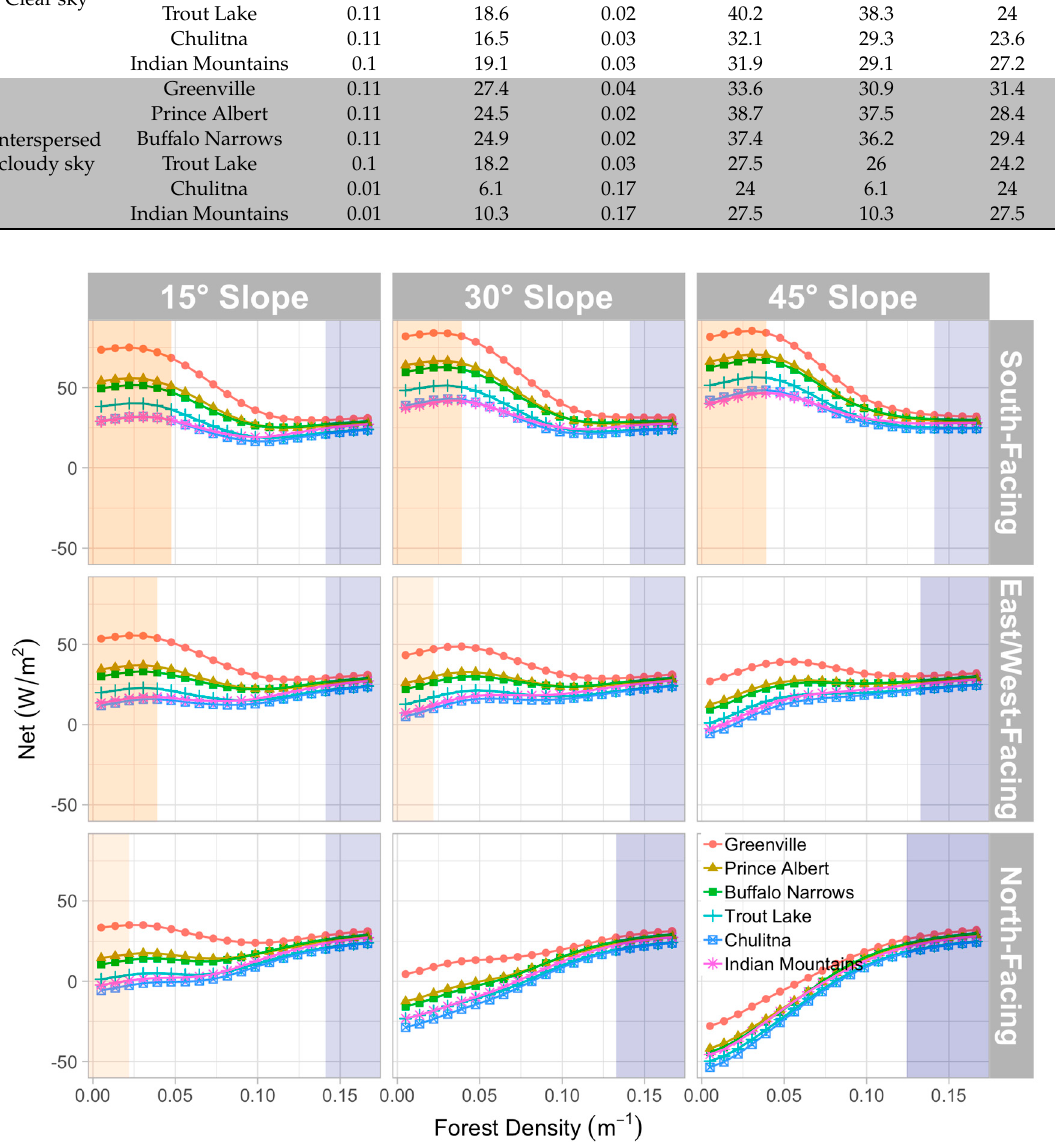
Figure 7. Variations of net radiation with vegetation density at di ff erent sites for di ff erent slope angles and aspects of the forested hillslope under clear sky conditions. Sites are listed in increasing order of latitude. The orange and purple bands indicate the vegetation densities for which shortwave ( ∆ S Net / ∆ L Net > 5) and longwave ( ∆ L Net / ∆ S Net > 5) radiation components dominantly control the variation with latitude, respectively. ∆ denotes the range of respective energy component for each